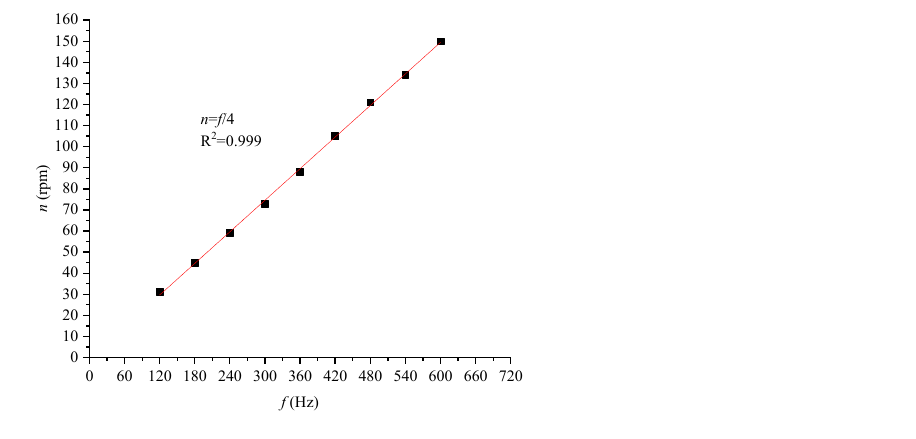
Figure 7. The relationship between the fertilizer flow rate and the frequency of PWM waves. The relationship between water flow rate and PWM wave duty cycle after testing is shown in Figure 8. After fitting, the relationship between the flow rate and PWM duty cycle can be expressed as follows: where q is the water flow rate (m 3 /h) and DC refers to the duty ratio.